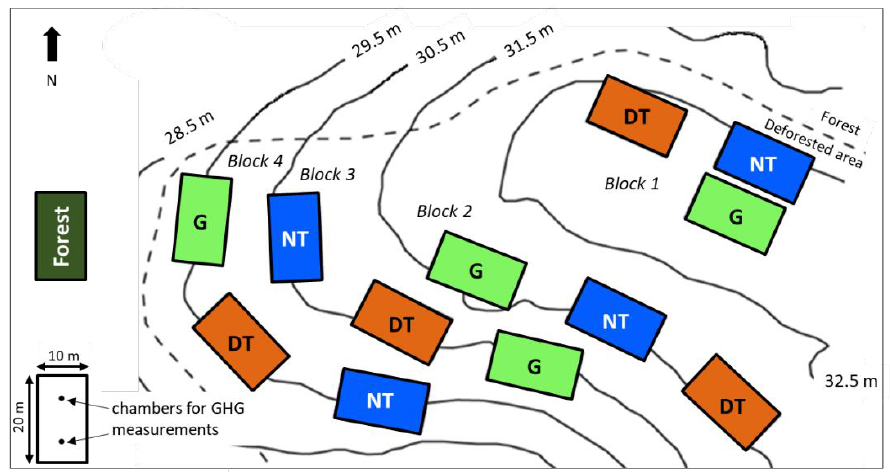
Figure 2. Experimental design at the Combi site (French Guiana): Randomized complete block design delimited over the deforested area. In the adjacent forest, one plot was also set up as a reference of the native ecosystem’s soil parameters and GHG fluxes. Two chambers were installed for soil gas measurements within each experimental plot. G = grassland, DT = disc tillage cropland, NT = no-tillage cropland.